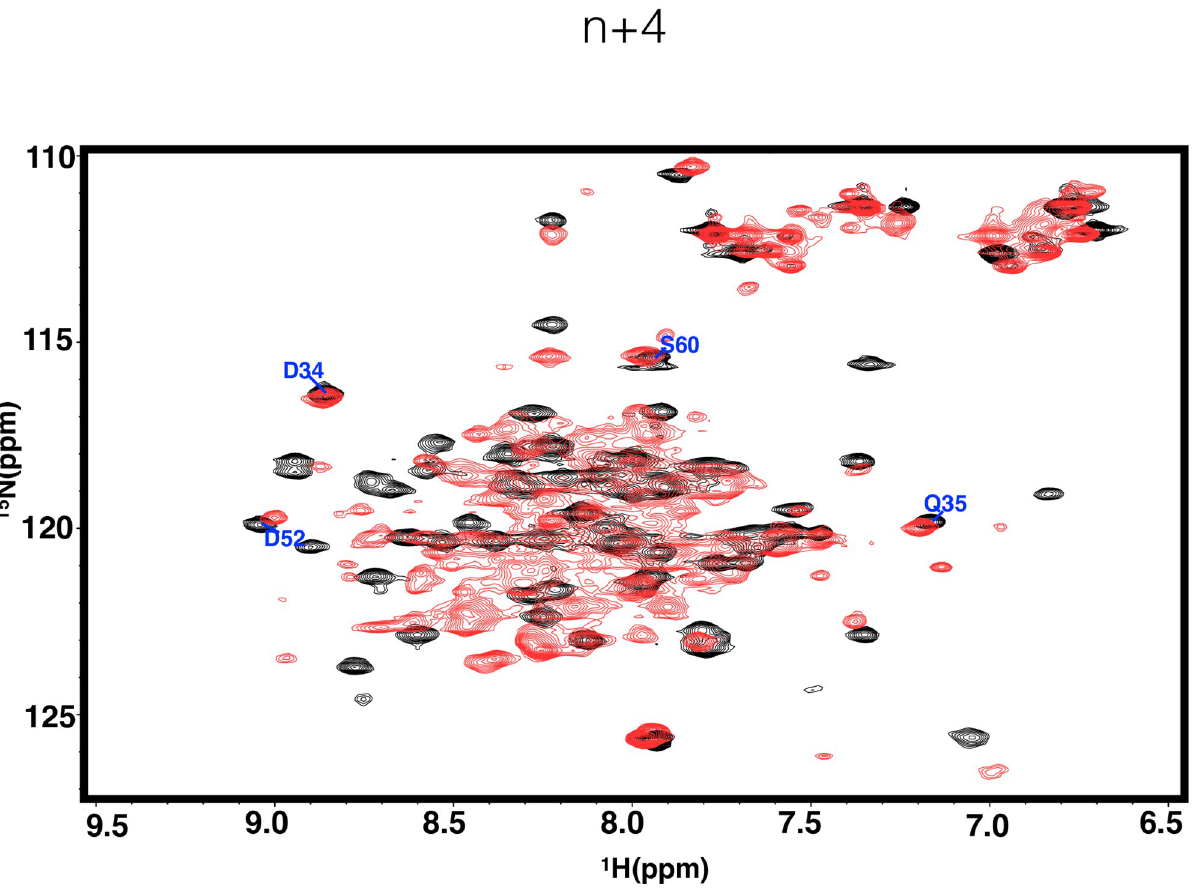
Fig 12. Two-dimensional 1 H - 15 N HSQC spectra of N terminal extension mutant (red) and wildtype (black).